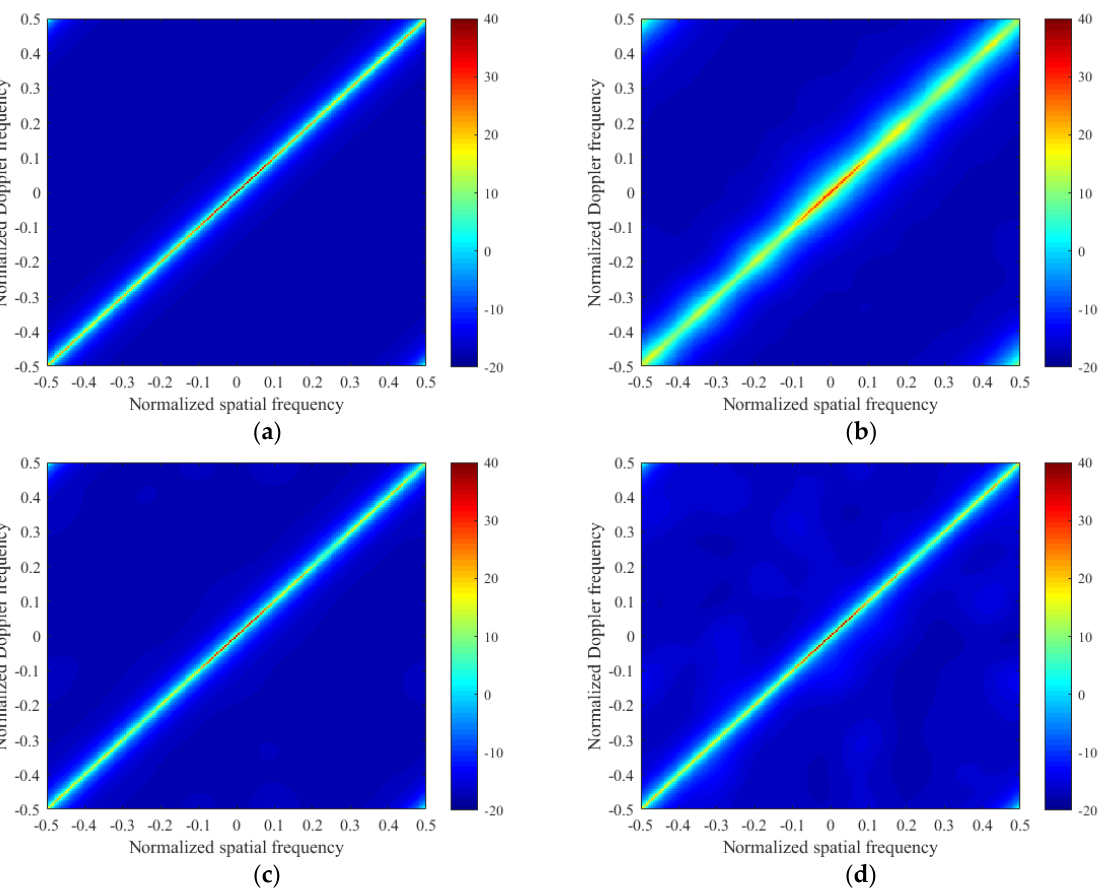
Figure 2. Comparison between the clutter angle-Doppler spectrum estimated by different algorithms